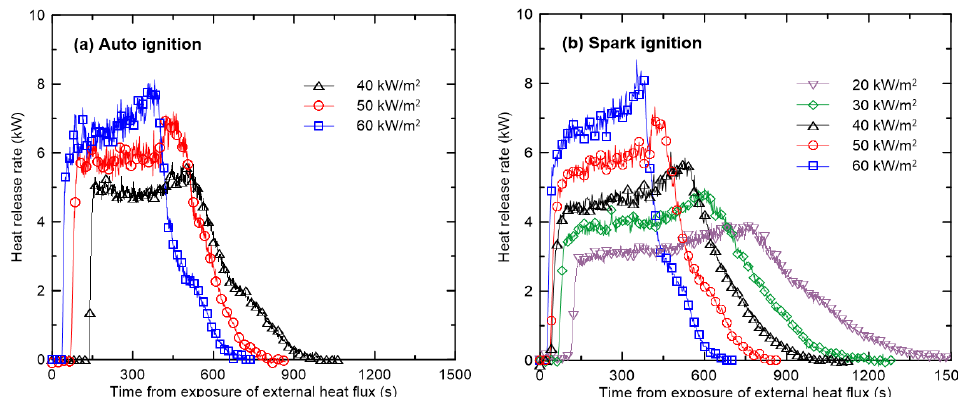
Figure 5. Time histories of heat release rate under the conditions of various external heat fluxes for the auto and spark ignitions.